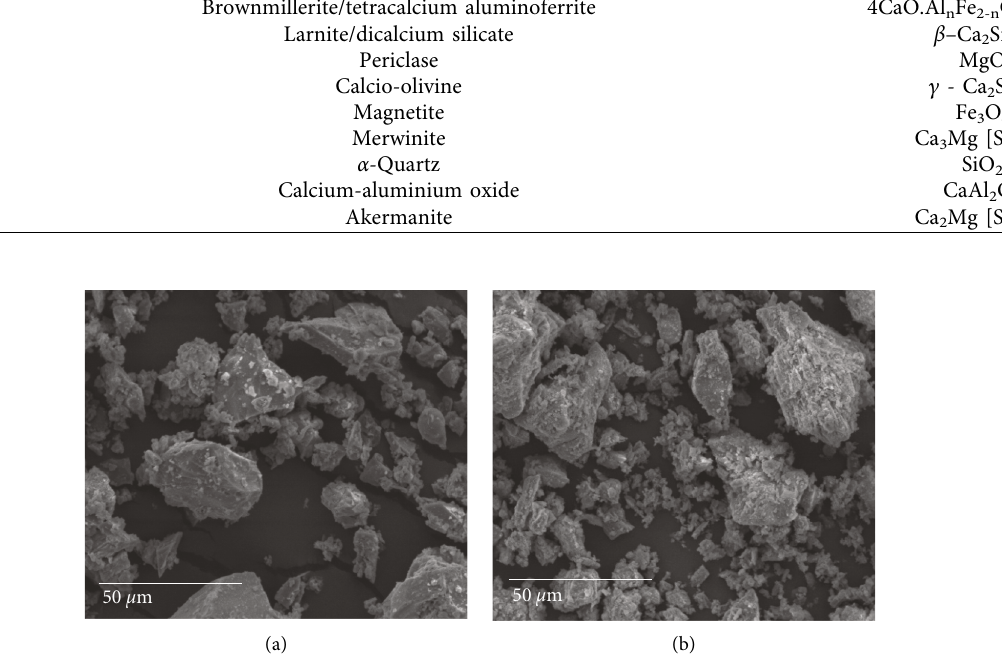
Figure 8: Morphology of (a) CEM-I and (b) LFS obtained from SEM.